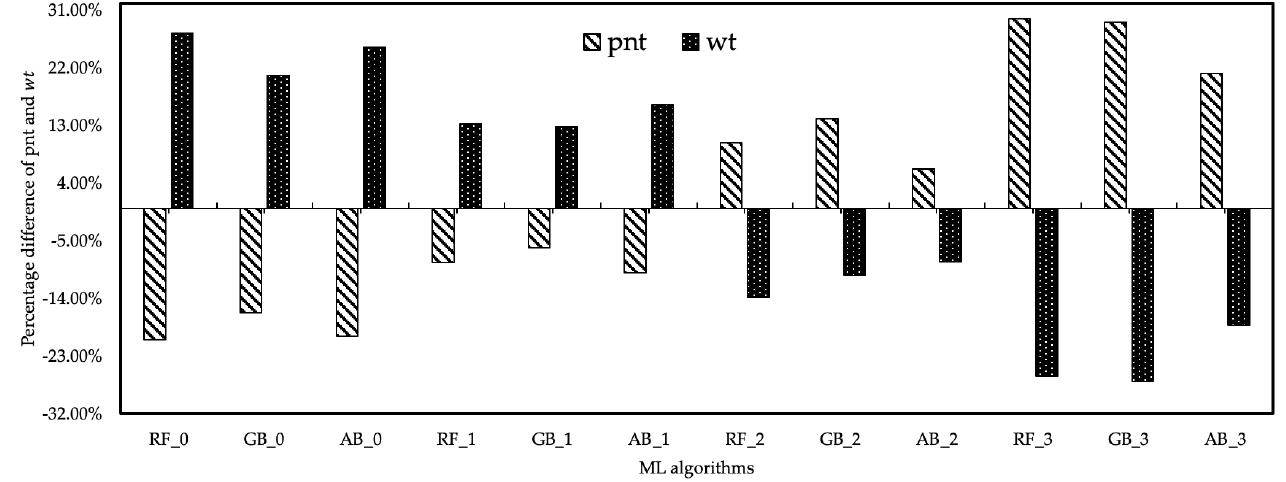
w t , and the minimum value of w t was obtained with this algorithm. Figure 9 expresses the percentage differences of fluctuation in the estimation data of ML algorithms based on the δ i of healthcare resources.